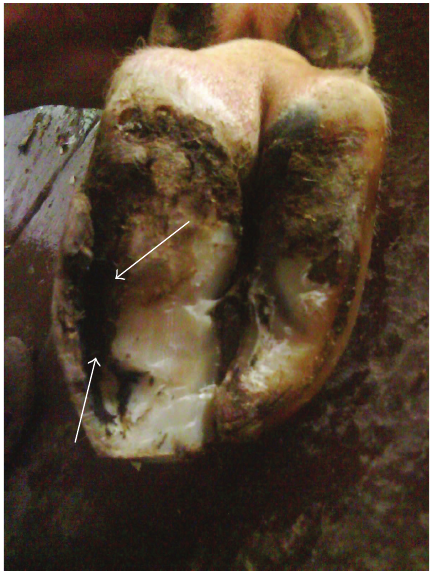
Figure 4: White line fissure.